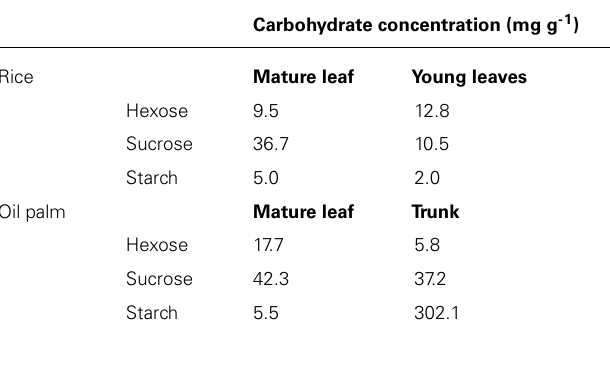
Table 1 | Mean concentration of non-structural carbohydrate at the beginning of the greenhouse experiments (onset of the dry-down) for rice (genotype IR64) and oil palm (genotype